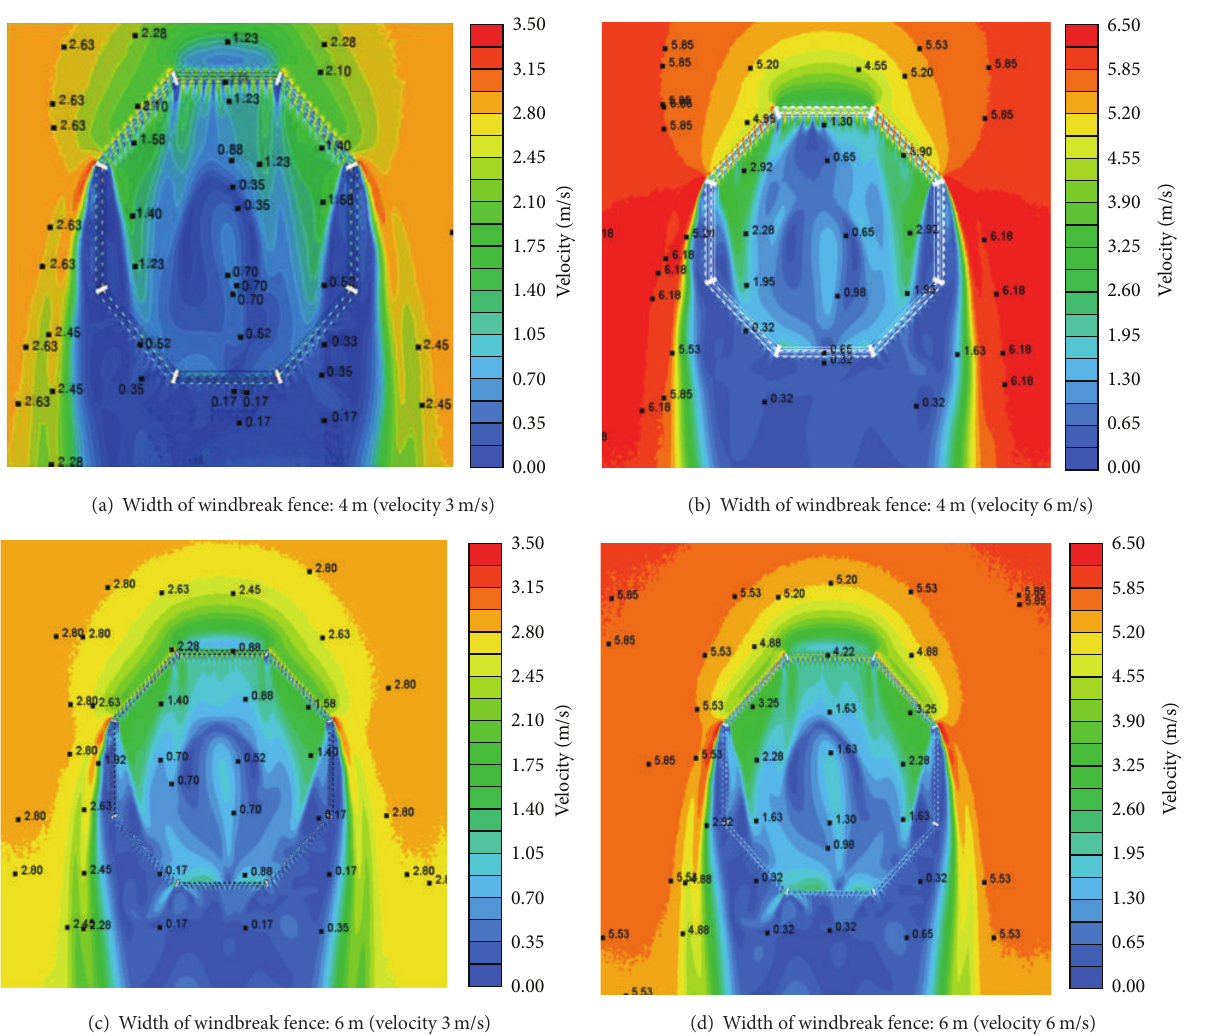
Figure 11: Internal wind velocity flow at a measurement height of 10cm according to the windbreak fence